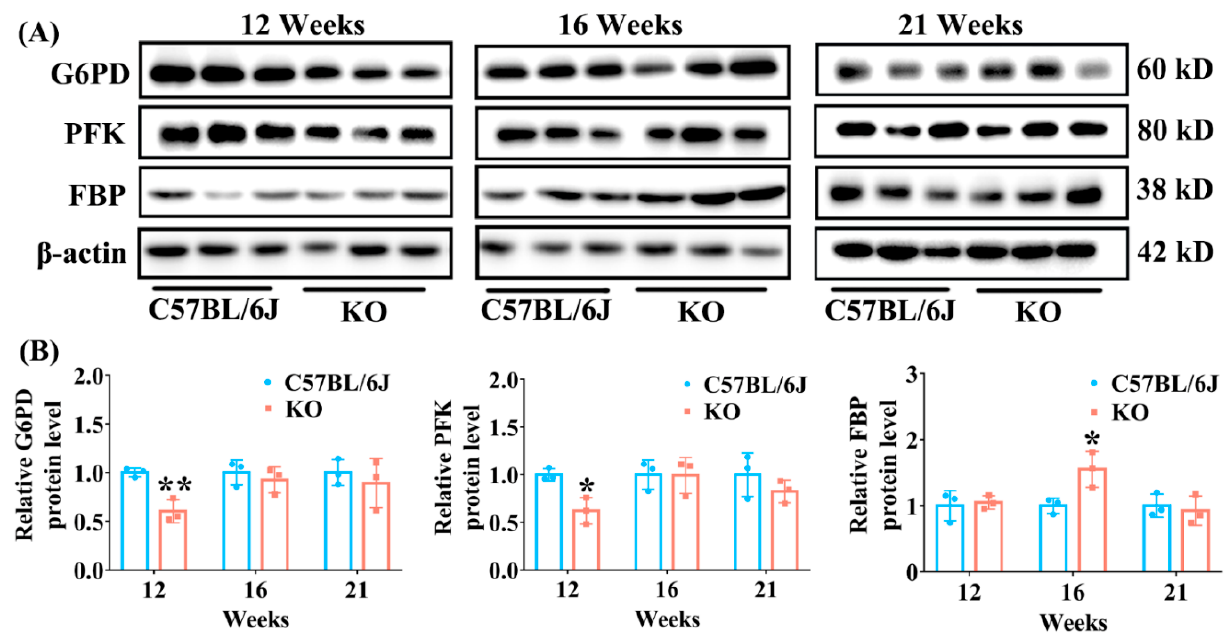
Figure 4. The expression of enzymes involved in glucose metabolism pathways in the liver of KO and C57BL/6J mice of different ages. ( A ) Representative Western blot bands of G6PD, PFK and FBP. ( B ) Semi ‐ quantification analysis of G6PD, PFK and FBP normalized to β‐ actin. G6PD: glucose 6 ‐ phosphate dehydrogenase; PFK: phosphofructokinase; FBP: fructose ‐ 1,6 ‐ bisphosphatase. Data were expressed as mean ± SD ( n = 3). * p < 0.05, ** p < 0.01, compared with C57BL/6J mice.